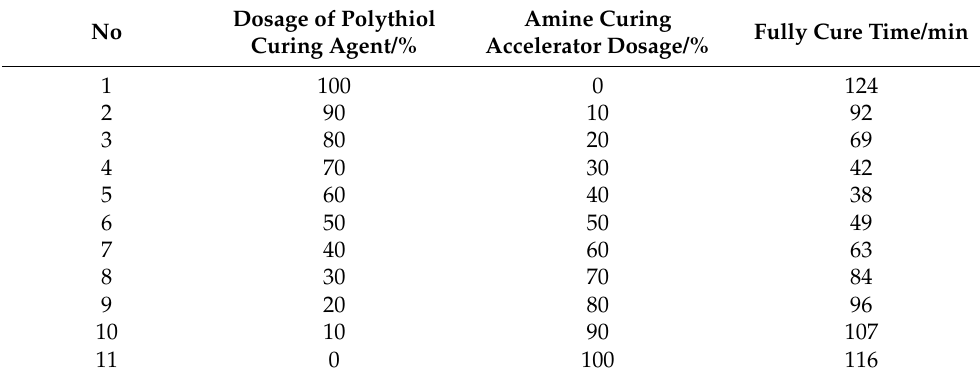
Table 1. Curing time of curing agent system with different